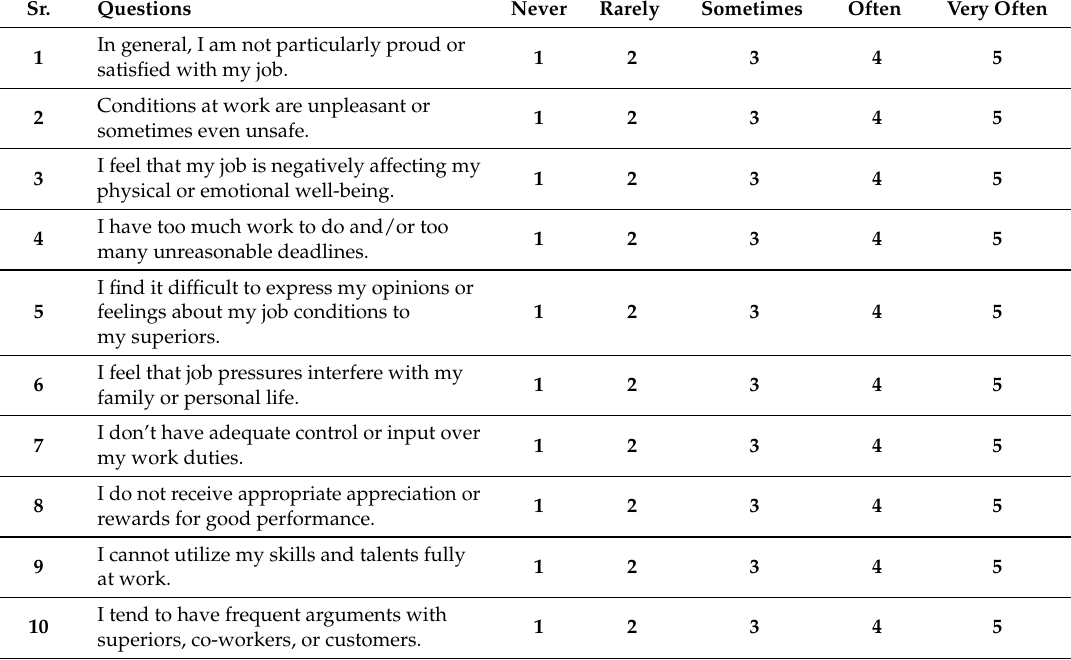
Table A1. Questionnaire from the American Institute of